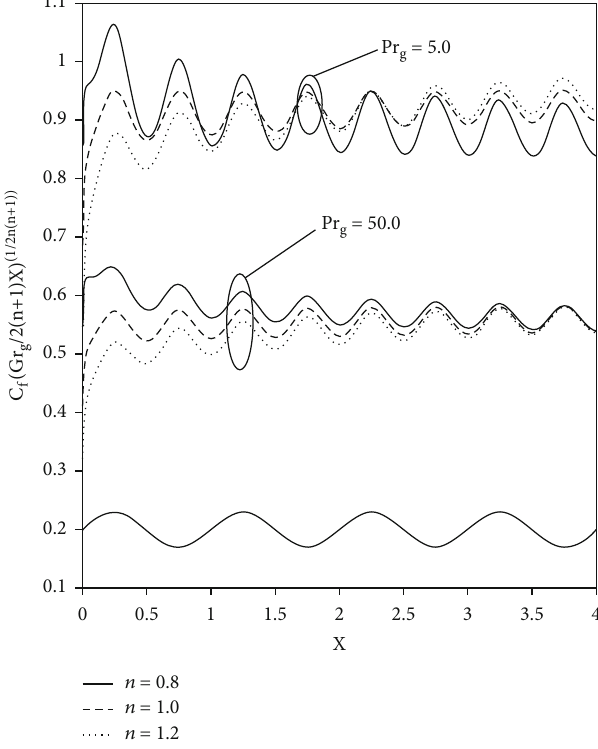
Figure 7: The axial distribution of the skin friction coe ffi cient for P = 5 -50, α = 0 : 1 , Br = 0 : 5 , Q = 0 , and n = 1 : 2